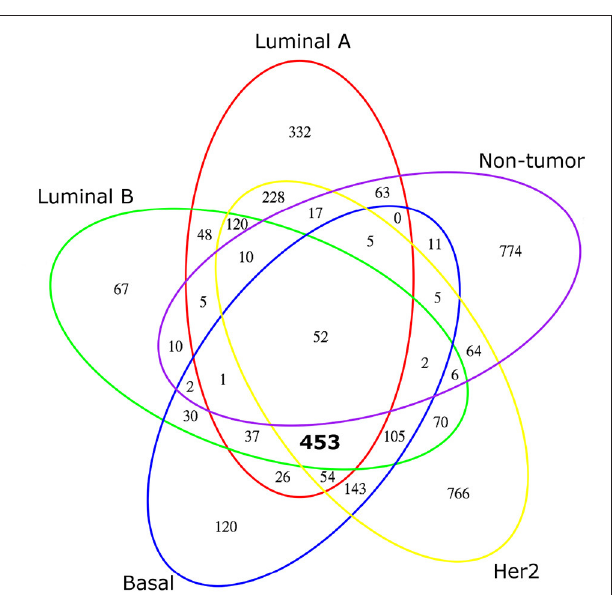
FIGURE 2 | Venn diagram of network node composition. A five-set Venn diagram of the nodes that form each transcriptional network: Luminal A is outlined in red, Luminal B in green, Basal in blue, HER2-enriched in yellow and non-tumor breast tissue in purple. Numbers in graph represent how many genes belong to each subset. Notice that the intersection of the four breast cancer molecular subtypes is large (453, marked in bold); meanwhile the number of shared genes between tumor and non-tumor networks is much smaller, with only 52 genes shared by all